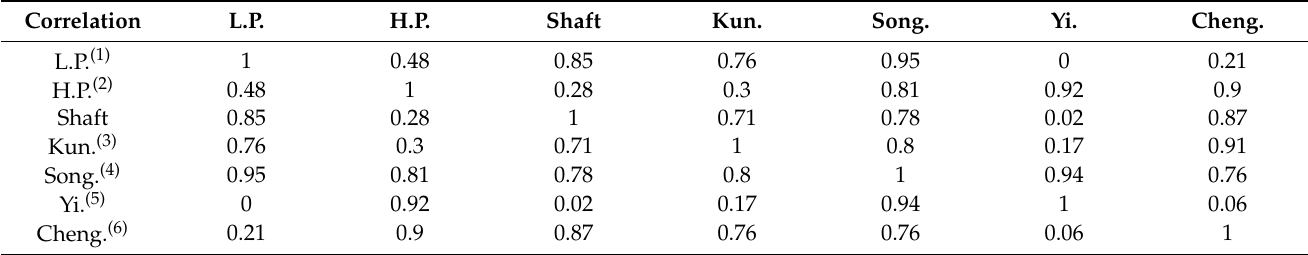
Table 2. Wind speed correlation analysis of each weather station.